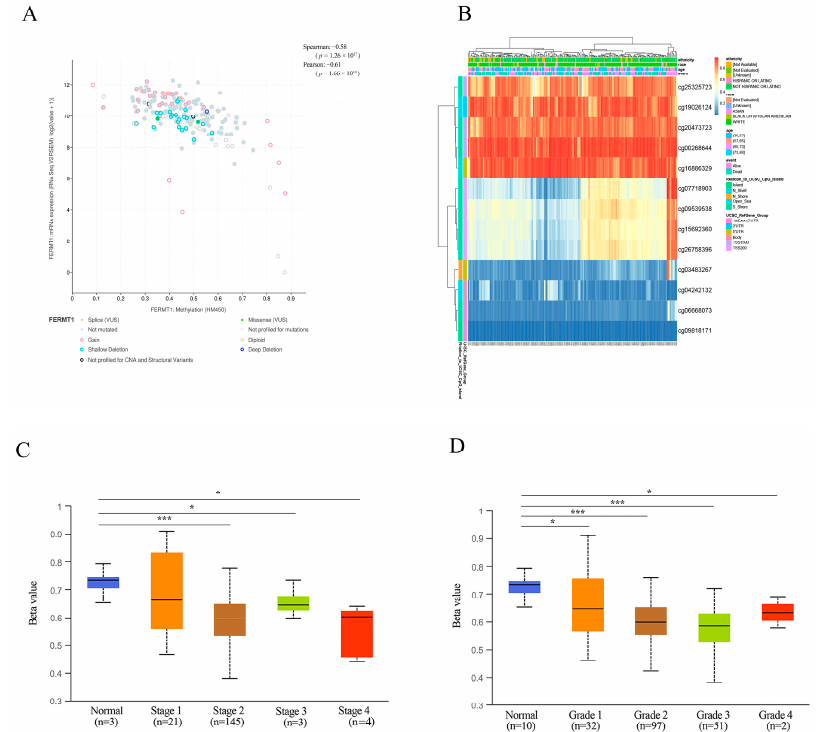
Figure 4. Correlation of FERMT1 with DNA methylation in PAAD. ( A ) Spearman and Pearson